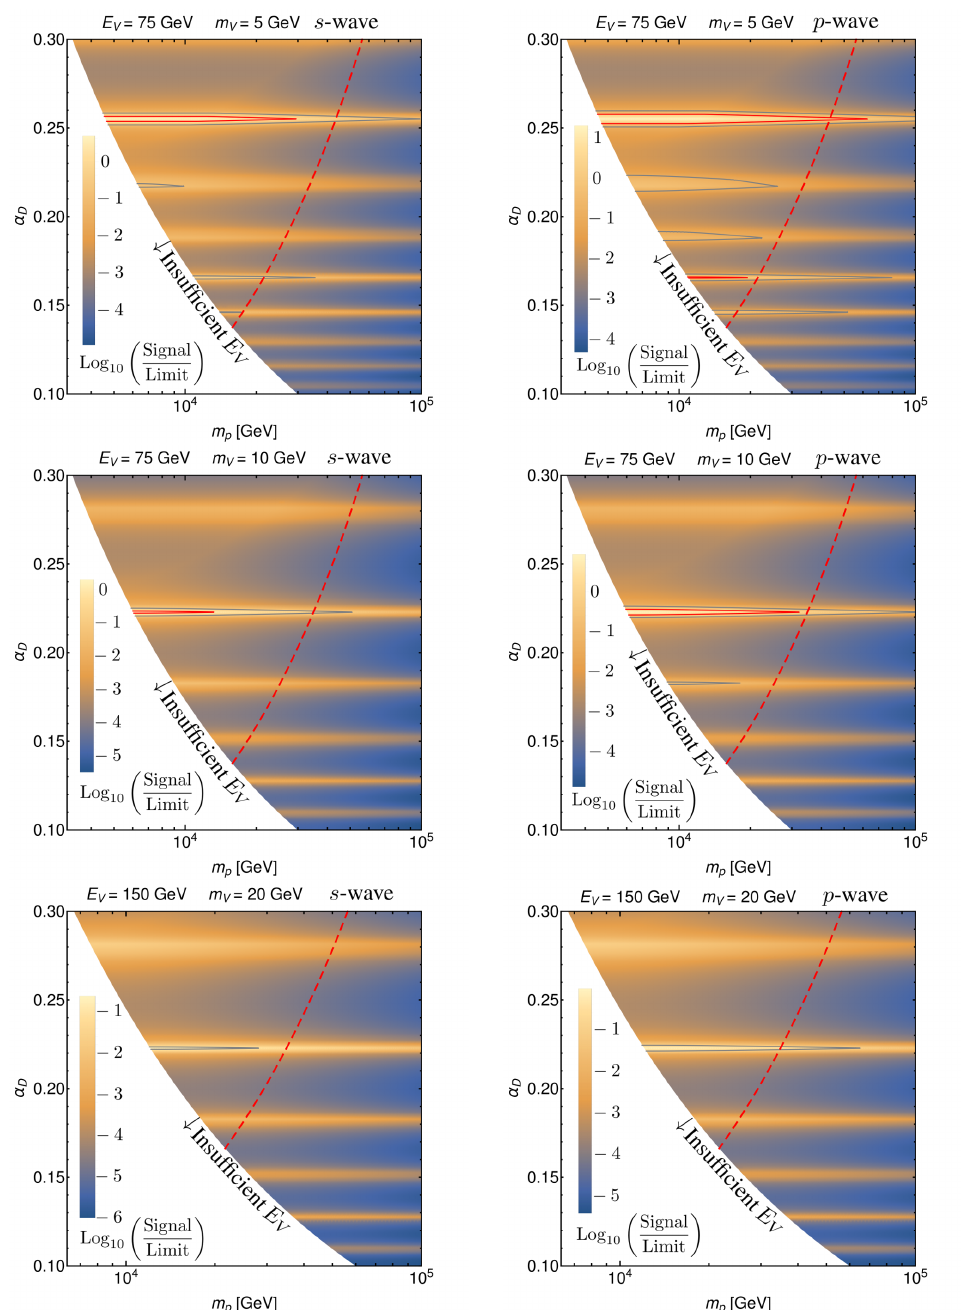
Figure 12: Limits from Fermi-LAT dSphs on bound state formation in the dark QED asymmetric DM model for three sets of parameters. The constrained regions are shown by a red contour. The grey contours show the would-be constrained regions if the limit on the flux were improved by a factor of ten. The DM relative velocity is = 20 km / s. We have enforced m < m set to v which implies we cannot reach e p rel the required E in the white regions of the plots. The red dashed line shows the V minimum allowed coupling to avoid overclosure in a standard thermal history [ 2,20 ] . The constraint using the s -wave ( p -wave) J -factor is shown on the left (right). The p -wave constraint is a factor of ≈ 4